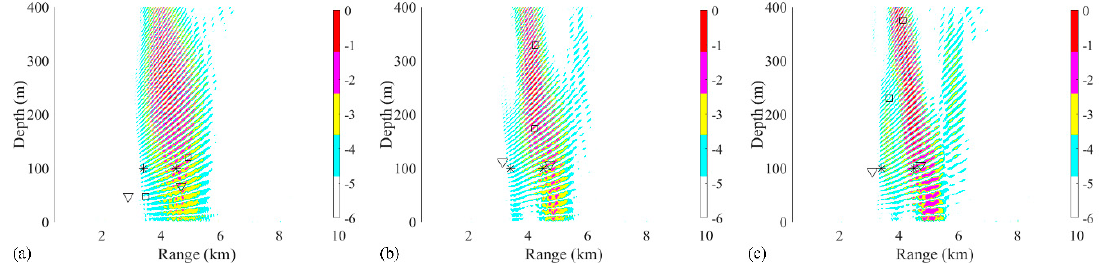
Figure 17. The ambiguity surfaces calculated by a Bartlett processor, the RAMP method, and the RAMPMF method with the apertures ( a ) 94 m; ( b ) 100 m; and ( c ) 112 m. True source positions and the positions estimated by the RAMP and RAMPMF methods are represented as black asterisks, squares, and inverted triangles, respectively.